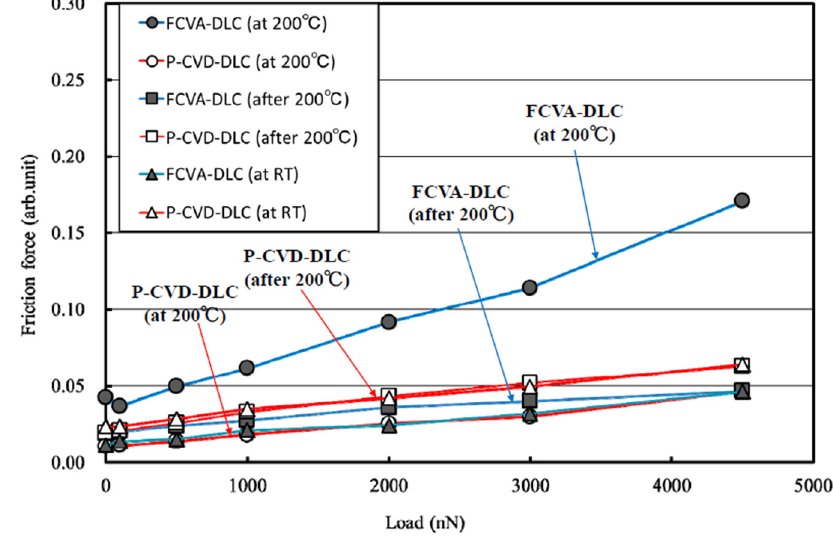
Figure 15. Nano - friction force dependence on load. (RT, 200 °C). Figure 15. Nano-friction force dependence on load. (RT, 200 ◦